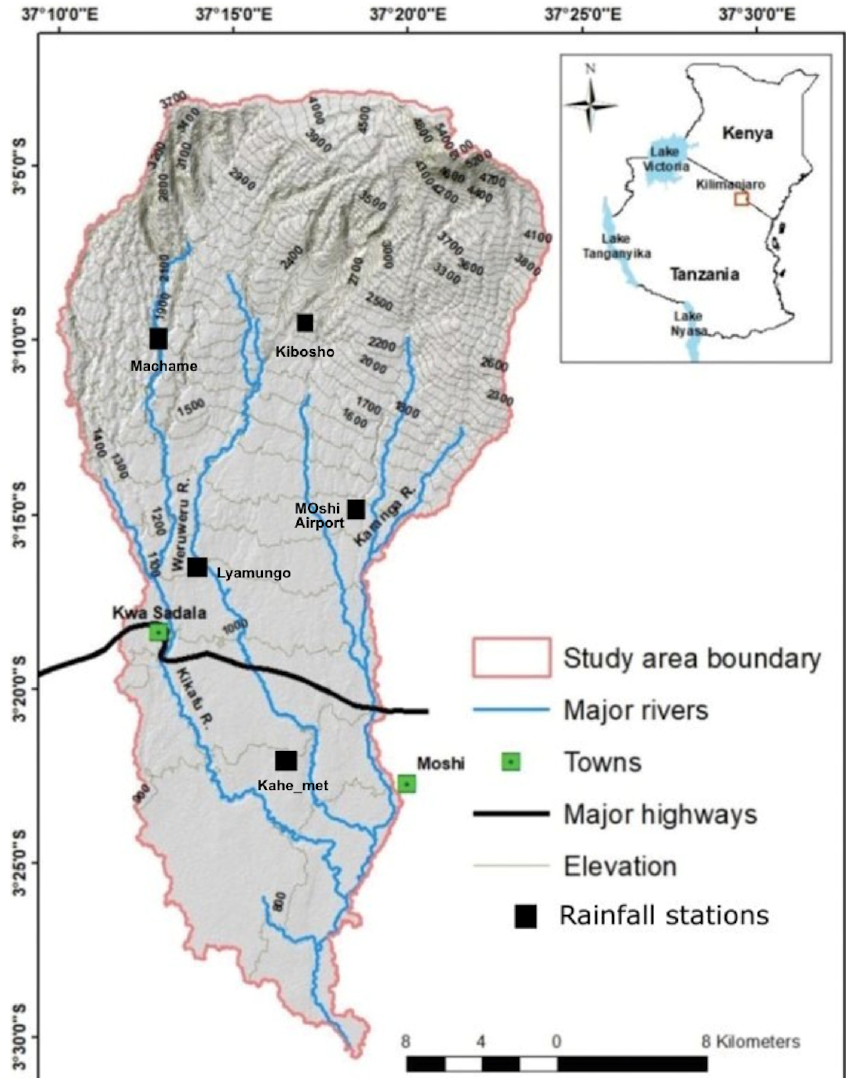
Figure 1. Karanga–Weruweru–Kikafu(KWK) sub-catchment. The data contain daily weather data from the five stations (Machame, Kibosho, Lya- mungo, Moshi Airport, and Kahe) for 35 years, with seven parameters, namely